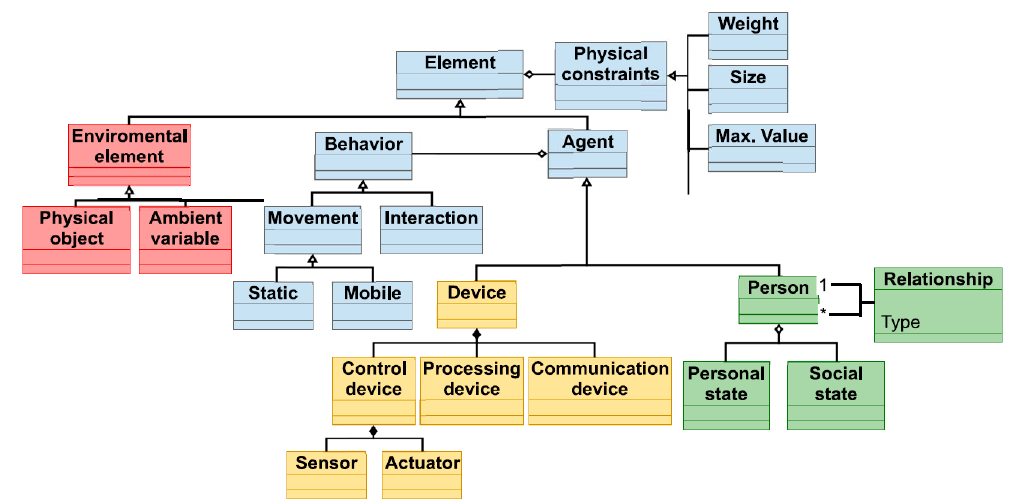
Figure 6. Base CPSS simulation model.